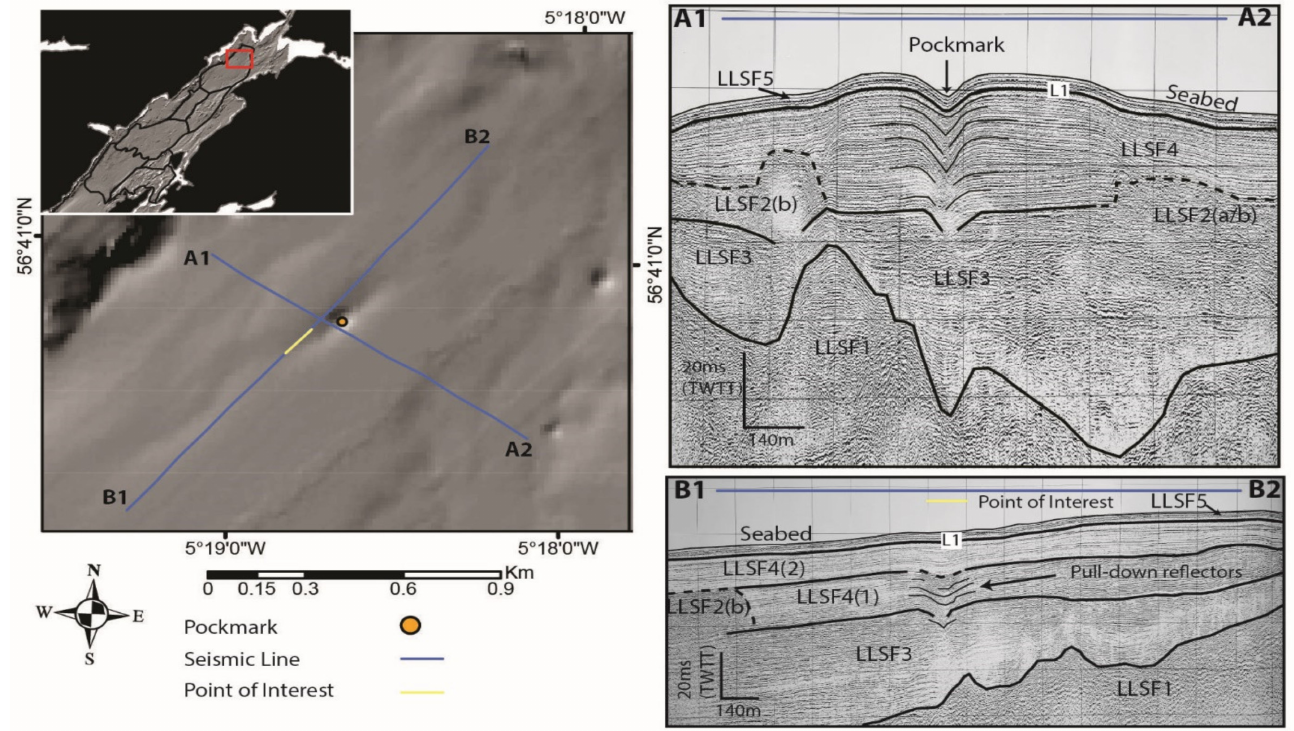
Figure 6. Analysis of selected seismic lines containing pockmarks and pull-down reflectors. Map shows the position of seismic lines, basin boundaries and the location of pockmarks that appear on seismic line. Labelled seismic lines sections correspond to the seismic profiles A:B. Seismic Line B is also shown in Figure 4 where gas-associated features are